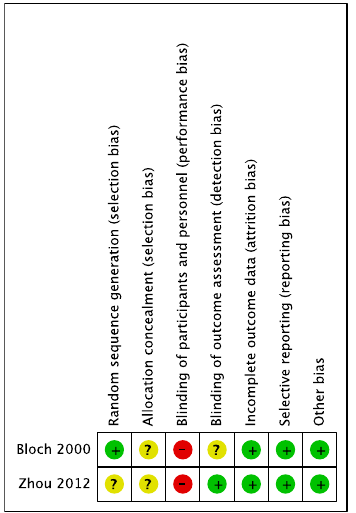
Figure 3. Assessment of risk of bias of the included studies (Mono-block OA m versus Bi-block OA m ) for systematic review.